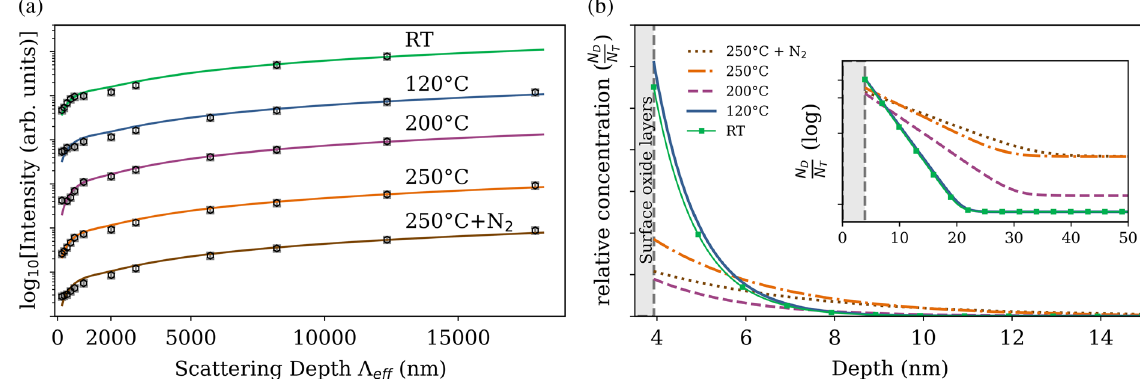
FIG. 7. (a) Diffuse scattering intensities obtained for each temperature step (squares) and the respective fit (solid line). The curves are offset in the y direction. (b) Interstitial concentration obtained from the fit plotted in the linear scale and the concentration in the log scale (inset). The profiles are represented by connected squares (room temperature), solid ( 120 °C), dashed ( 200 °C), dot-dashed ( 250 °C), and dotted lines ( 250 °C under a N 2 atmosphere).